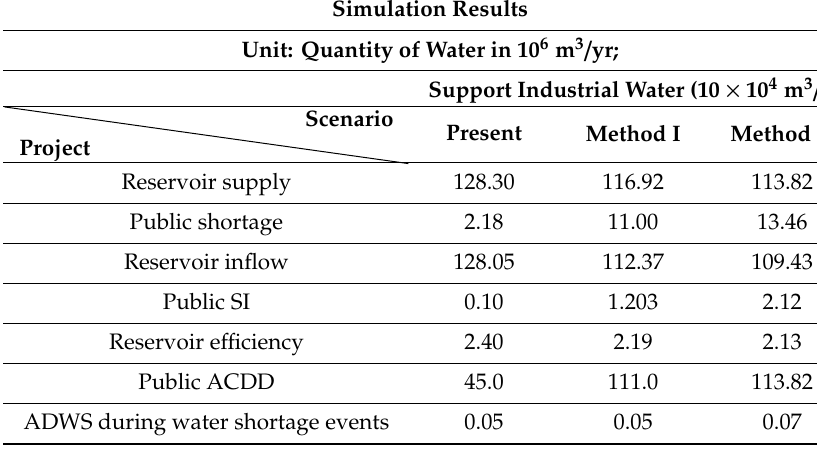
Table 8. Comparison of historical and synthesis flow data.